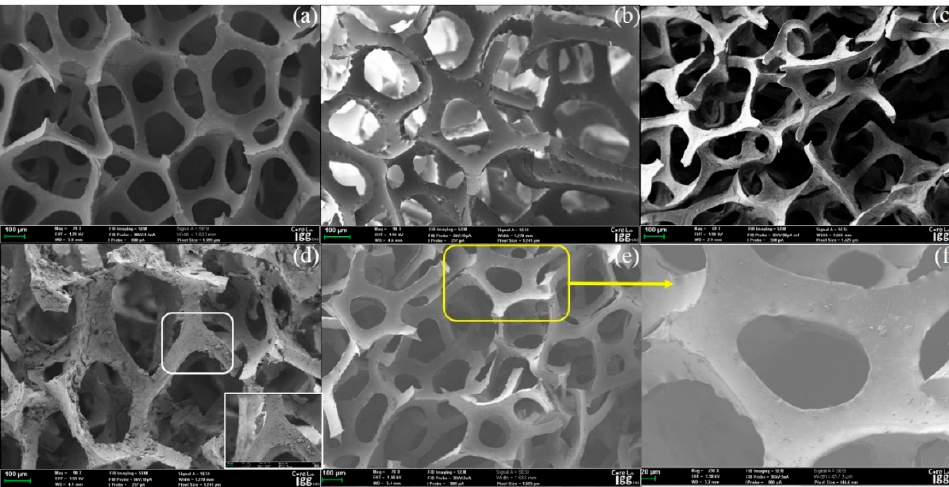
Figure 1. SEM image of ( a ) raw PU, ( b ) APU, ( c ) GB@PU, ( d ) PE-DA@GB@PU, and ( e )